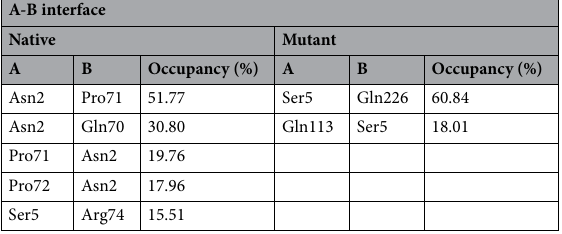
Table 1. Main hydrogen interactions were obtained with the last 100 ns of the MD simulation and their respective